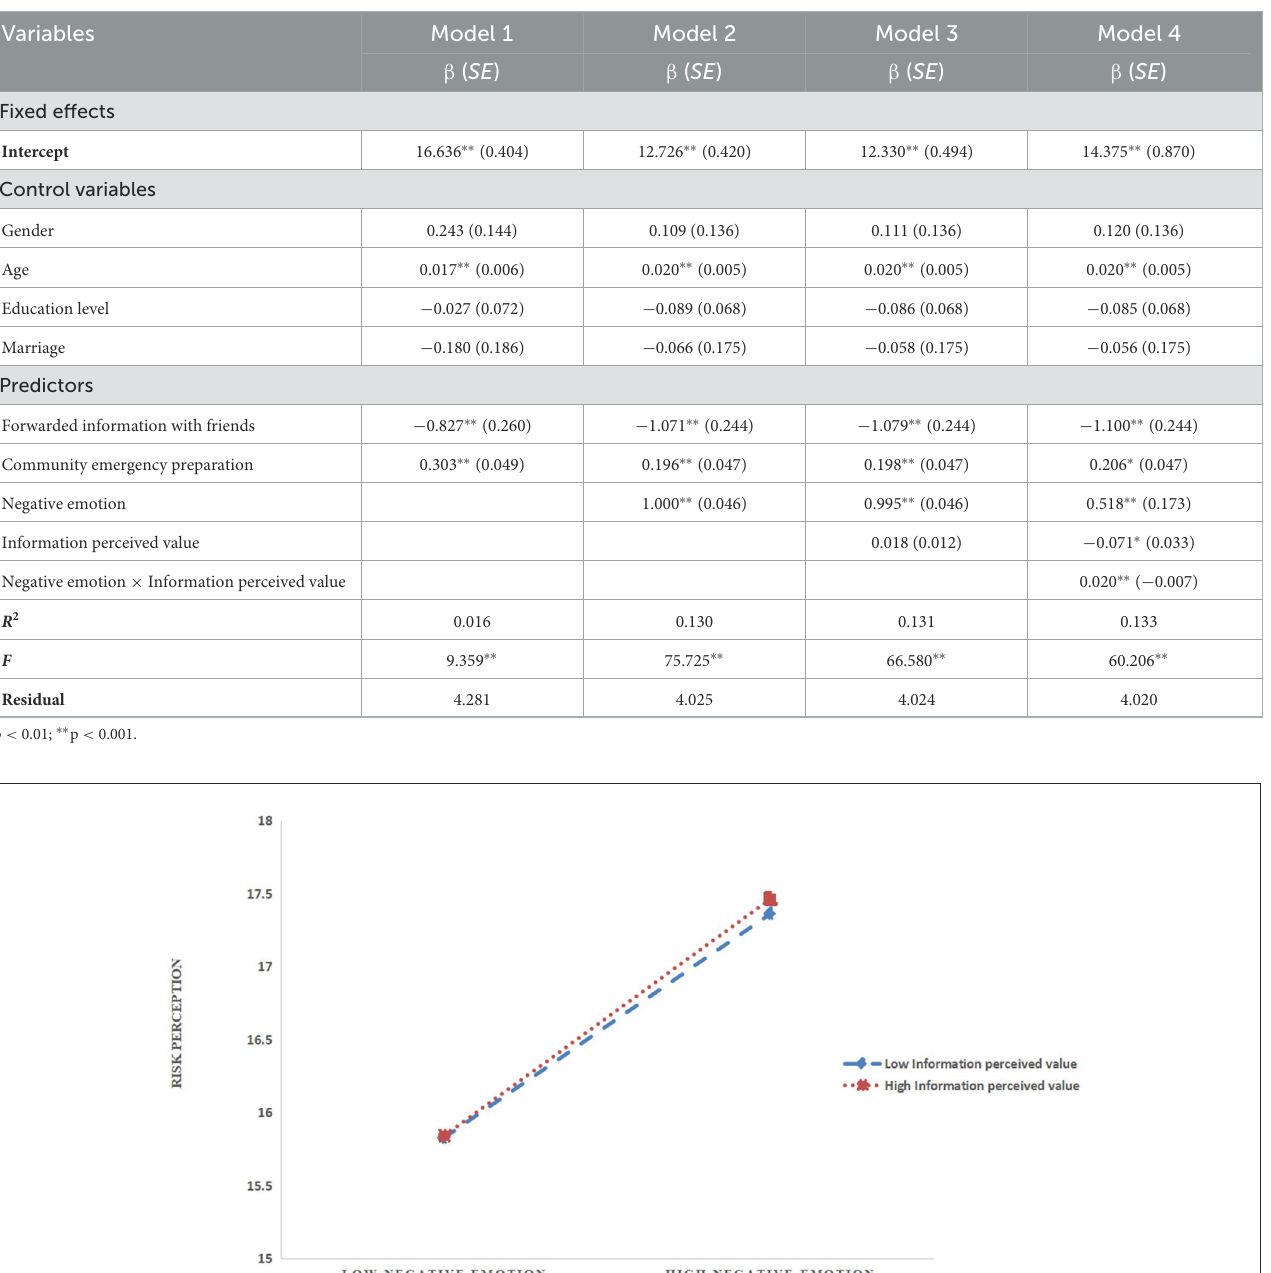
TABLE 3 Regression coefficients of moderating interaction effects test.